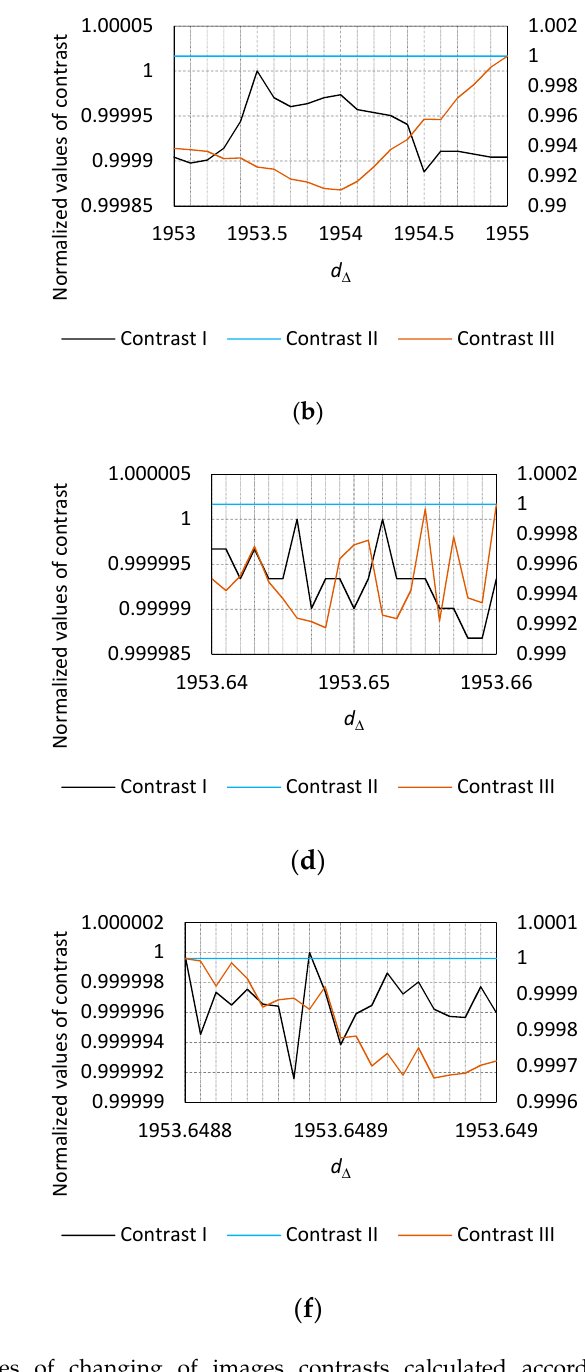
Figure 10. Normalized values of changing of images contrasts calculated according to equations (2), (8) and (11) in domain of image line length 𝑑 ∆ for different accuracies Δ : ( a ) ∆= 1.0 , ( b ) ∆= 0.1 , ( c ) ∆= 0.01 , ( d ) ∆= 0.001 , ( e ) ∆= 0.0001 , ( f ) ∆= 0.00001 , original image Figure 7a